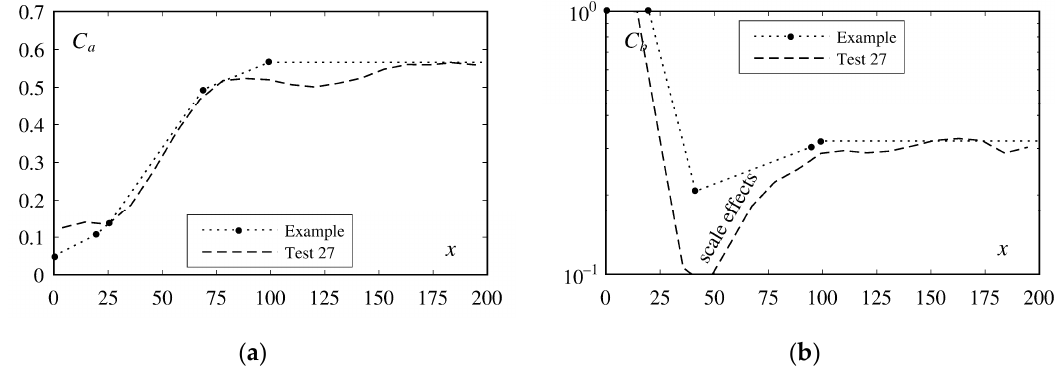
Figure 16. Comparison of the air concentration development between the example and test 27